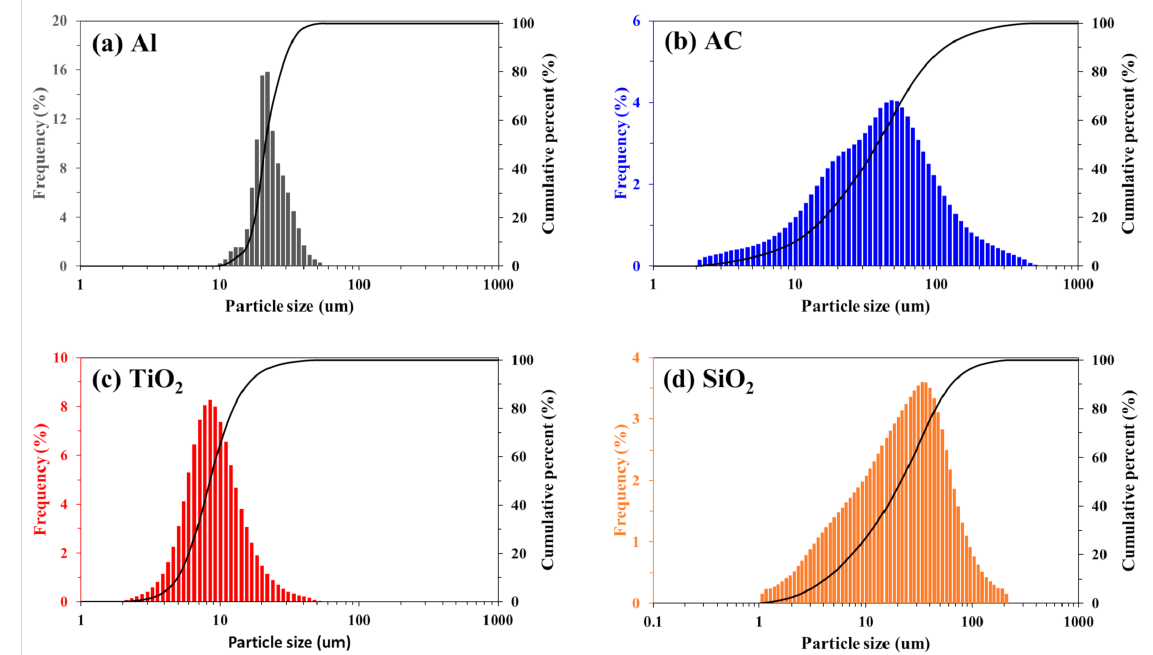
Figure 1. Particle size distribution for ( a ) aluminum (Al), ( b ) activated carbon (AC), ( c ) titanium dioxide (TiO 2 ), and ( d ) silicon dioxide (SiO 2 ) used in this